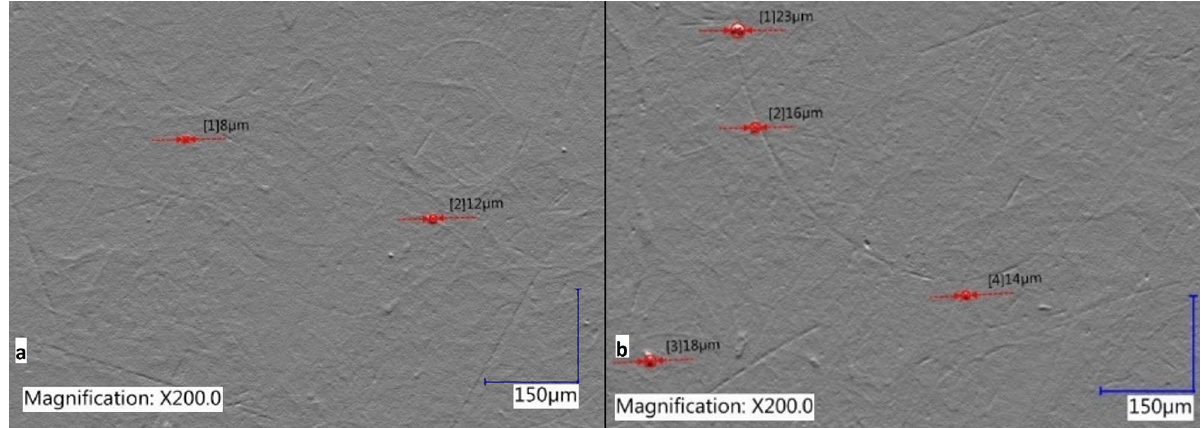
Figure 9. Example of measurements of droplet marks diameters for ( a ) S0 Sample; ( b ) S2